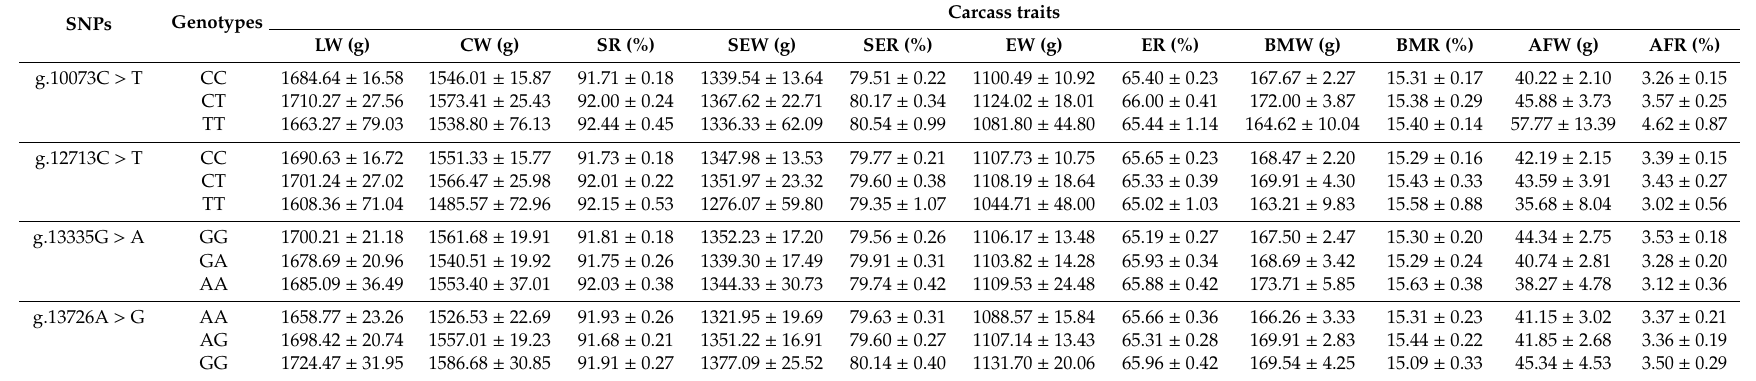
Table 6. Association of four SNPs of the PITX2 gene with carcass traits in Wuliang Mountain Black-bone chickens ( MEAN ± SE ).